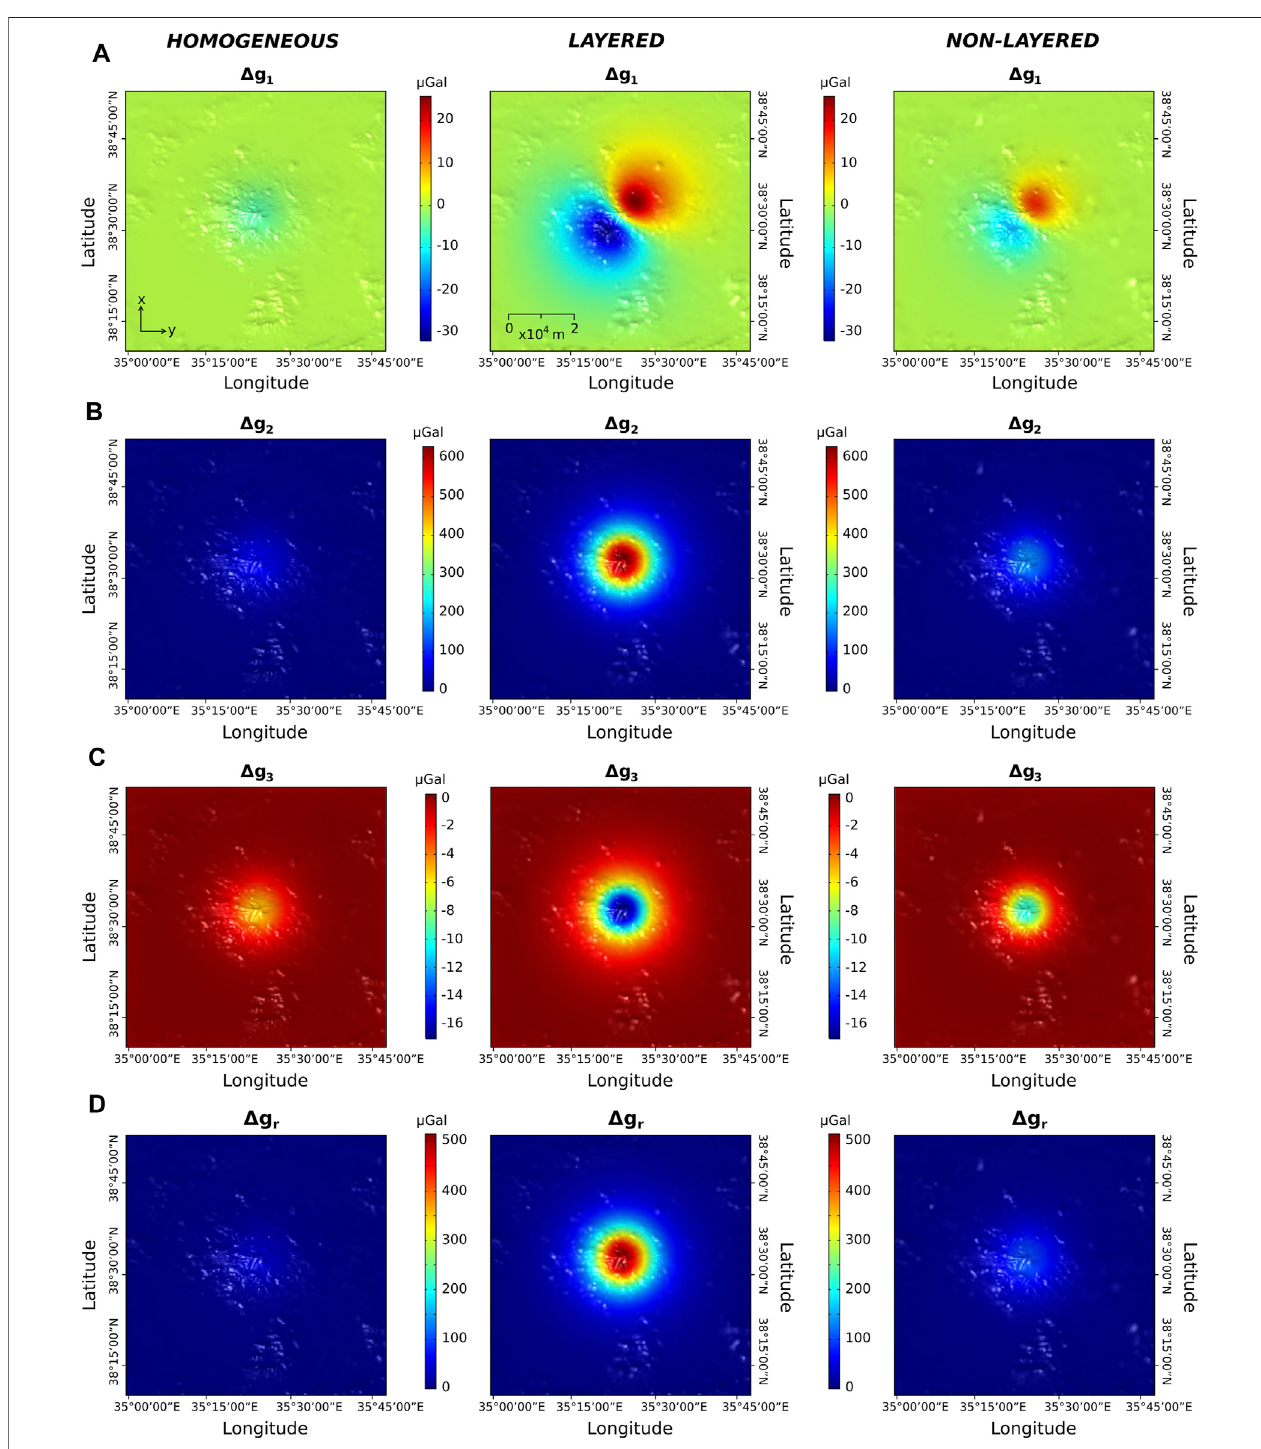
FIGURE 6 | Gravity variations at Erciyes Da ğ from generic TM, LTM and NLTM simulations using parameters reported in Table 3 . (A – C) show contributions from gravity terms Δ g 1 , Δ g 2 and Δ g 3 , respectively ( Eqs 2 , 3 ). (D) shows the resultant residual gravity changes Δ g r (see Eq. 5 ). The color bars depict the same range in values for each gravity change component, facilitating comparison of variations in magnitudes of gravity changes across different models.